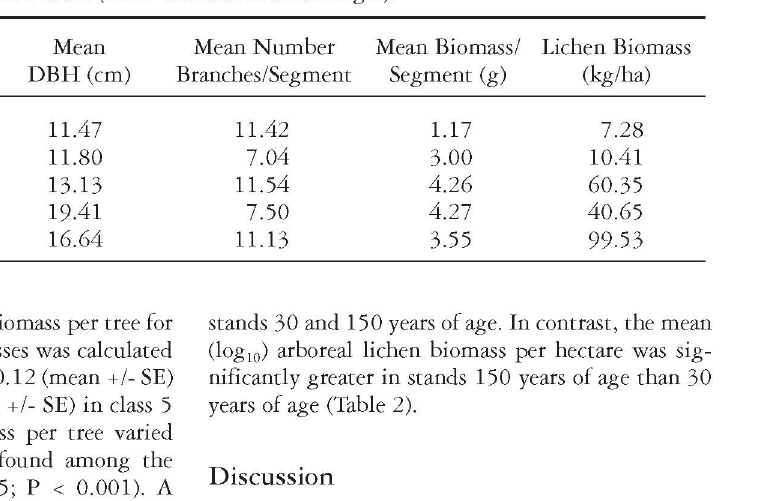
Table 2. Stand characteristics and arboreal lichen biomass (kg/ha) available to woodland caribou in lowland black spruce sites from northeastern Ontario (DBH=diameter at breast